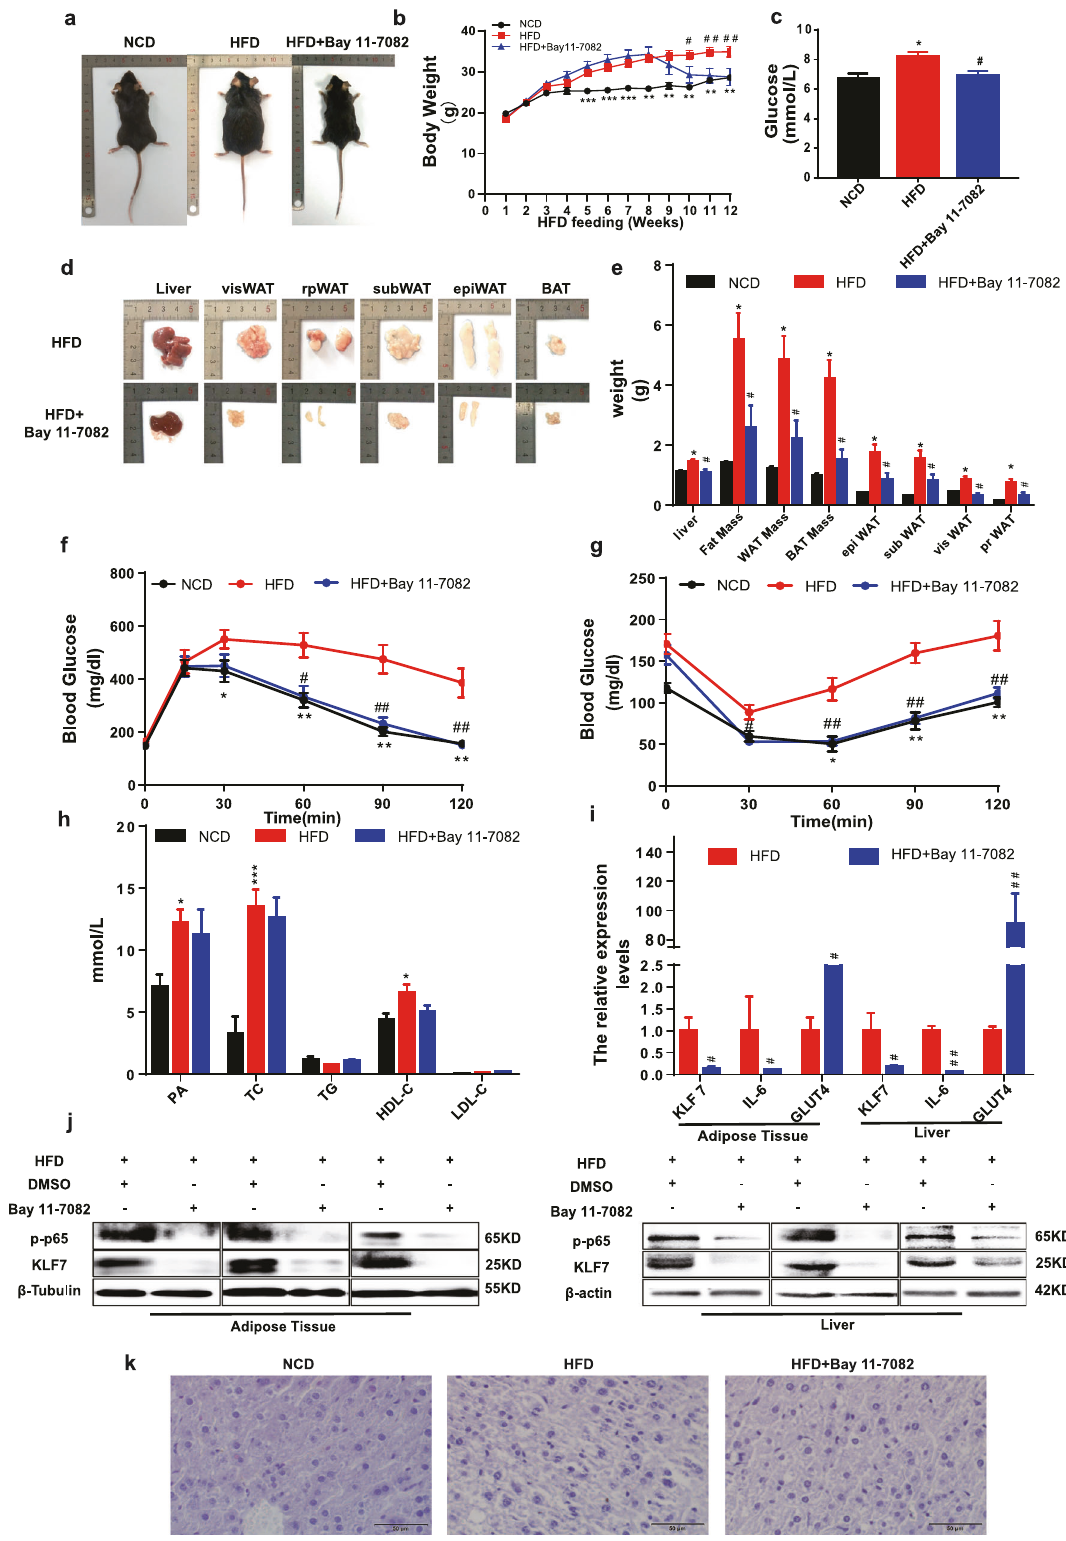
Fig. 6 The pharmacological effects of inhibit NF- κ B. Male C57B/L6 mice were fed with NCD or HFD for 7 weeks, then mice in HFD group were divided into two groups, HFD group and mice intraperitoneally injected with Bay 11-7082 (2.5 mg/kg/day) for 5 weeks. Dynamic changes in body of NCD, HFD, and Bay 11-7082 group ( a , b ). Weight of liver, epiWAT, subWAT, visWAT, prWAT in NCD ( n = 5), HFD ( n = 8), and Bay 11- 7082 group ( n = 6) ( d , e ). Blood glucose, GTT and ITT in NCD, HFD, and Bay 11-7082 group ( c , f , g ). Plasma levels of palmitic acid, TG, TC, LDL, HDL ( h ). Western blot of p-p65 and KLF7 in the murine epiWAT and liver ( j ). mRNA levels of KLF7, IL-6, GLUT4 in epiWAT and liver ( i ). HE staining of liver from mice ( k ). One-way ANOVA-LSD, t -test, *NCD compared with HFD group, # HFD compared with HFD + Bay 11-7082 group. * p < 0.05, ** p < 0.01, *** p < 0.001, # p < 0.05, ## p < 0.01, ### p < 0.001, the difference was statistically signi fi cant, data presented as means ±